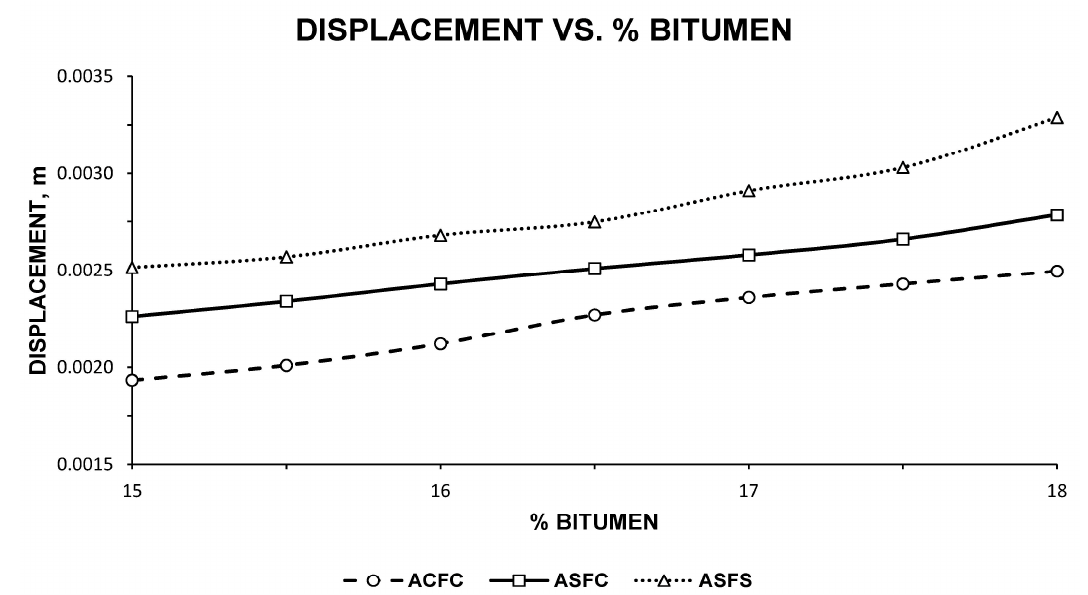
Figure 7. Marshall deformation of the families of bituminous mixtures ACFC, ASFC and ASFS with different percentages of bitumen in volume of aggregate.